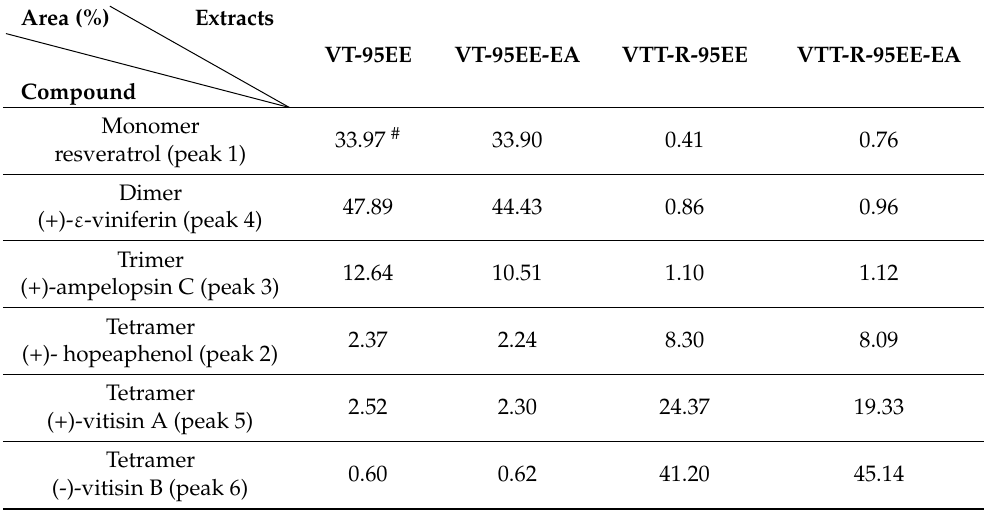
Table 1. The composition profiles of identified resveratrol and its oligomers in HPLC chromatograms of extracts and partitioned fractions #